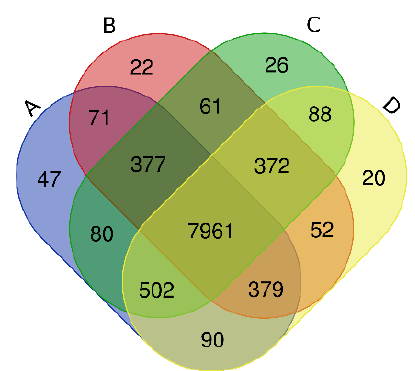
Figure 1. Venn diagrams of the total operational taxonomic units (OTUs) in Haplic Cambisols treated with different concentrations of graphene and different incubation times (A: 0 mg kg −1 ; B: 10 mg kg −1 ; C: 100 mg kg −1 ; D: 1000 mg kg −1 ).